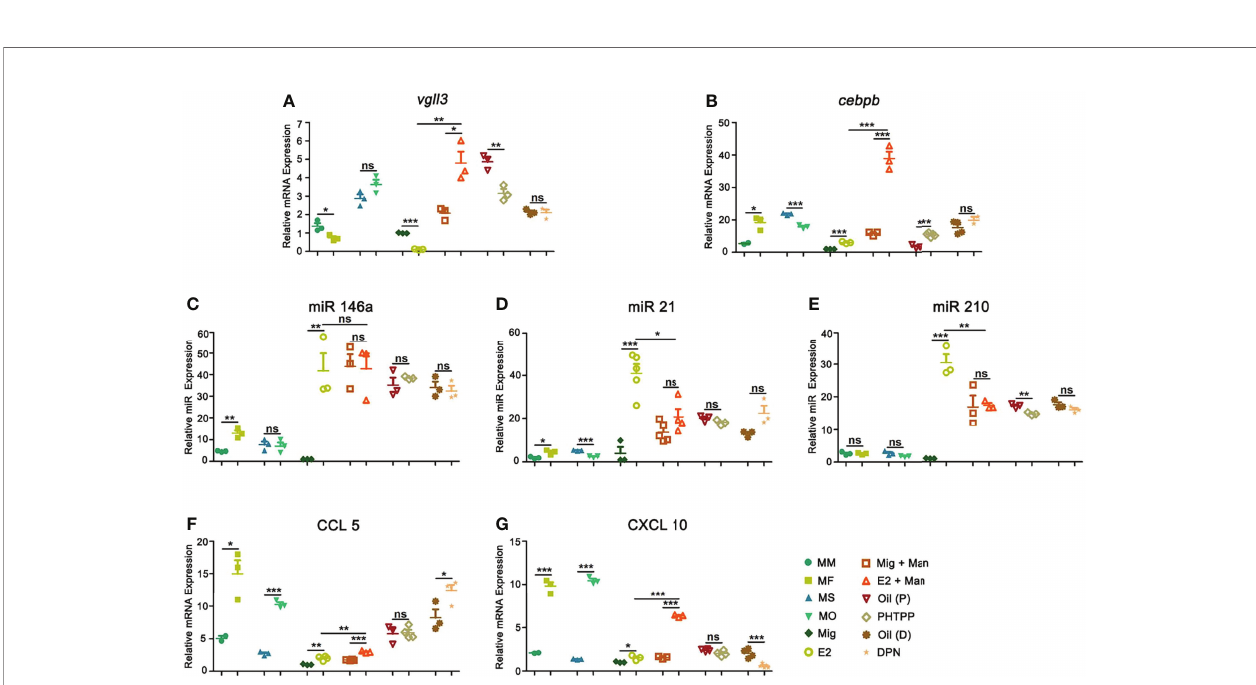
FIGURE 8 | Estrogen increased psoriasis by affecting certain genes, microRNAs, and chemokines. Expression of (A) Vgll3 , (B) cebpb , (C) miR146a, (D) miR21, (E) miR210, (F) CCL5, and (G) CXCL10 in male, female, OVX and sham operated, E2 or miglyol, PHTPP or DPN treated mice with and without mannan application (n = 5/group) in the skin. Each experiment was repeated twice. Man, mannan; MM, Man + Male; MF, Man + Female; MO, Man + OVX; MS, Man + Sham; Mig, miglyol; E2, 17- b -estradiol; Oil (P), E2 + Corn oil + Man; PHTPP, E2 + PHTPP + Man; Oil (D), Corn oil + Man; DPN, DPN + Man. Statistical analyses were performed using an unpaired t test. n, number of mice. The data represent mean ± SEM. ns, not signi fi cant. *p < 0.05; **p < 0.01. ***p <